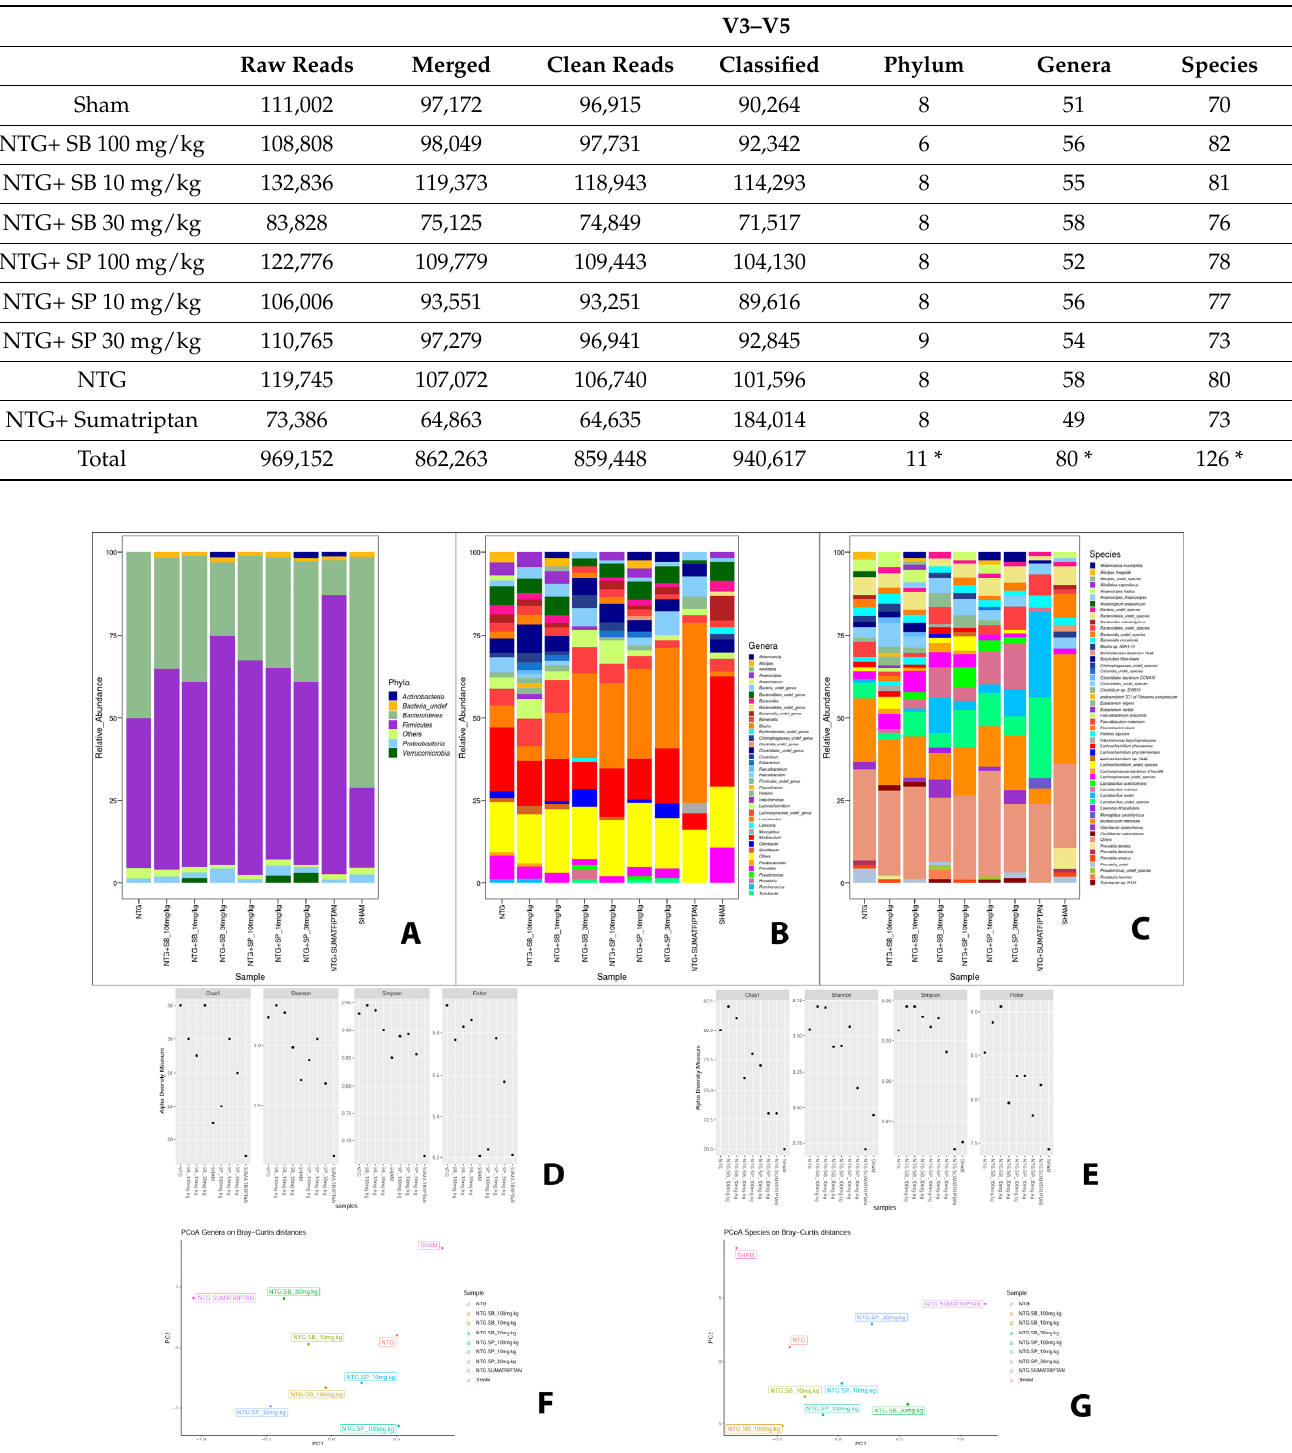
Figure 8. Overall intestinal microbiota composition and diversity over NTG-induced migraine, treatment with SP, SB and sumatriptan. Most abundant ( A ) phyla, ( B ) genera and ( C ) species observed in this study among the different conditions. Content in species explained by alpha diversity at genus ( D ) and species ( E ) levels. PCO plots based on Bray–Curtis, distance showing the differences among the intestinal microbial community of our sample at genus ( F ) and species ( G ) level. Table 1. Bioinformatic metrics and number of Taxa identified. Marked with dash the number of unique taxa found through the samples. V3–V5